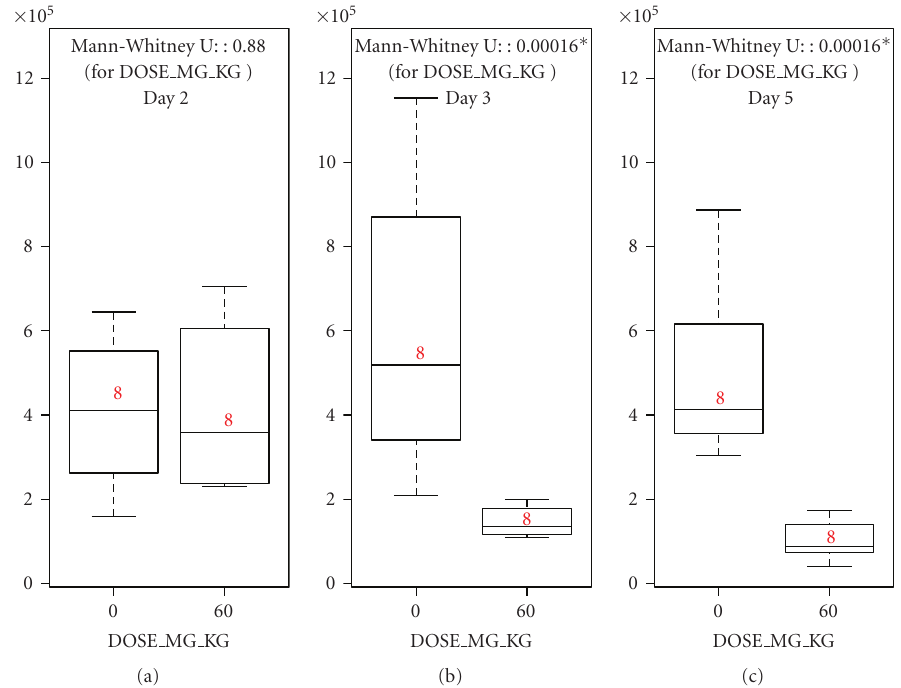
Figure 5: Examples for output generated by meta P- server : boxplots produced for groupwise hypothesis tests applied to the data set from the walk-through example provided with meta P- server ; the association between ophthalmate and drug dose is tested for each day of treatment separately producing three separated box